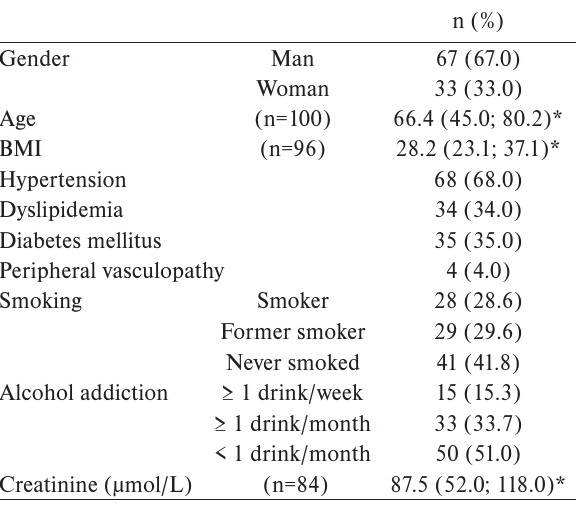
Table 1. Baseline